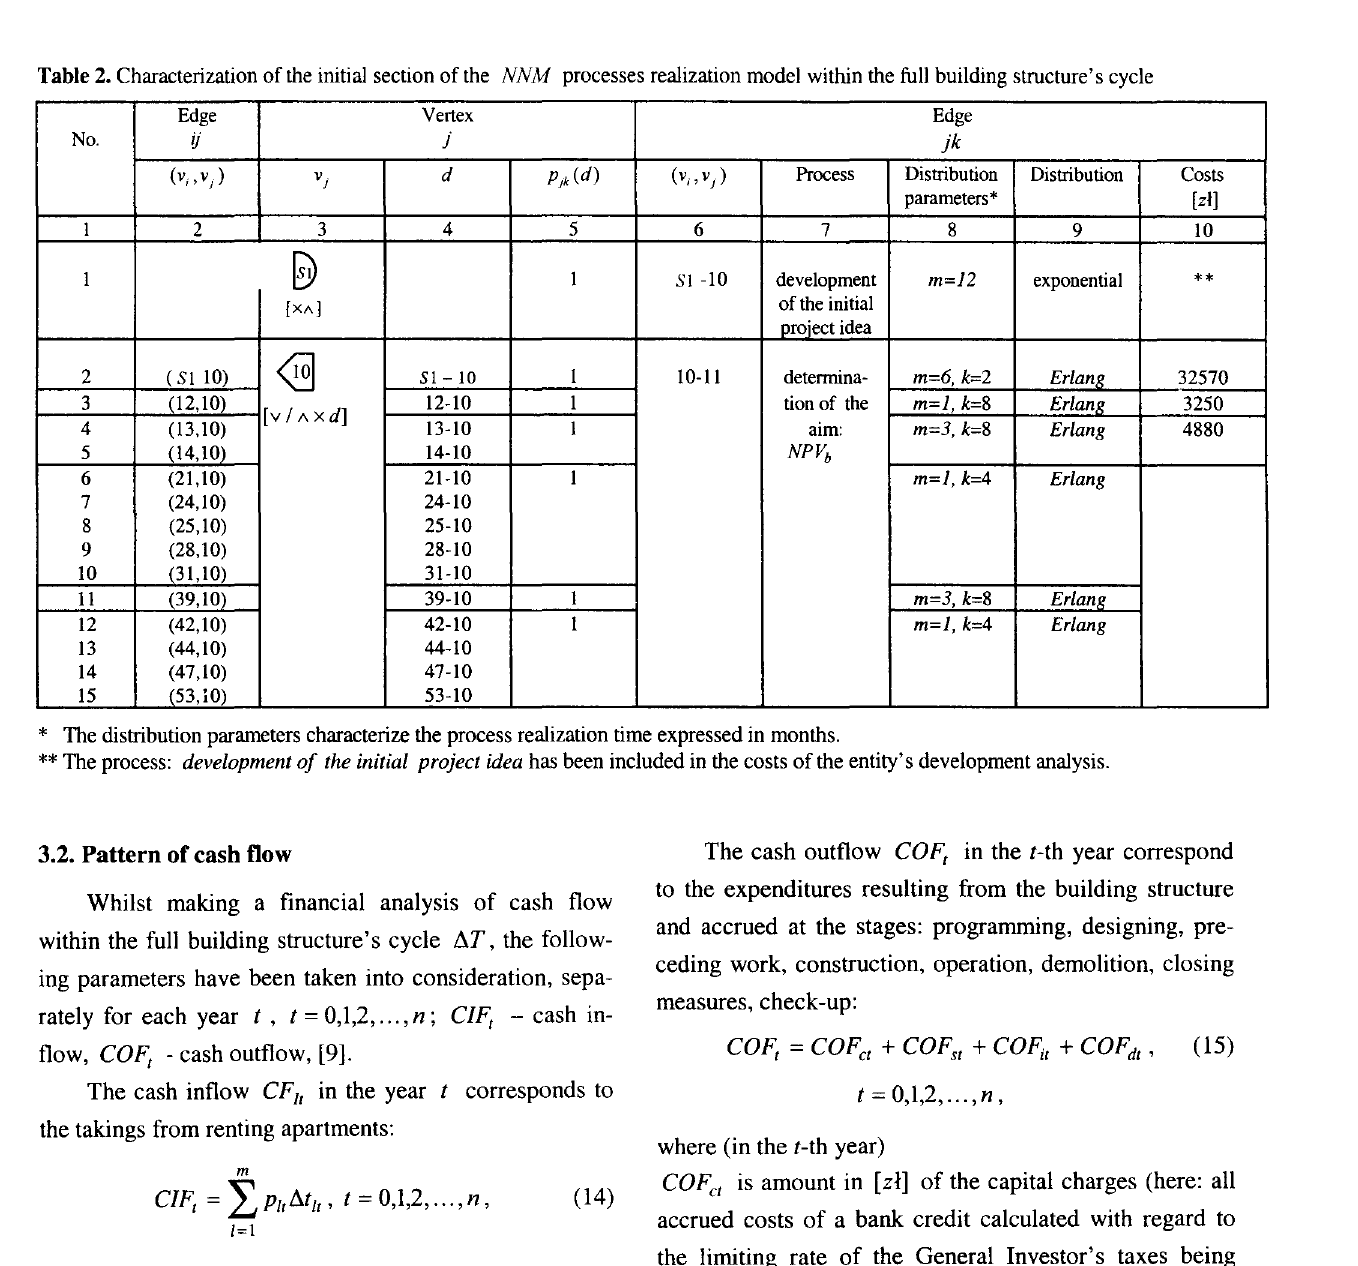
Table 2. Characterization of the initial section of the NNM processes realization model within the full building structure's cycle Edge Vertex Edge No. ij jk Process Distribution Distribution Costs parameters*